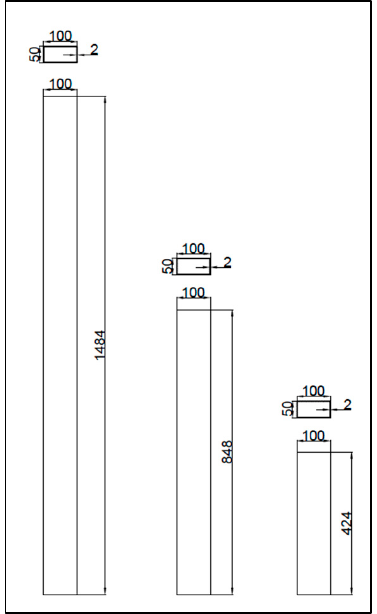
Figure 1. Specifications of the column with dimensions.